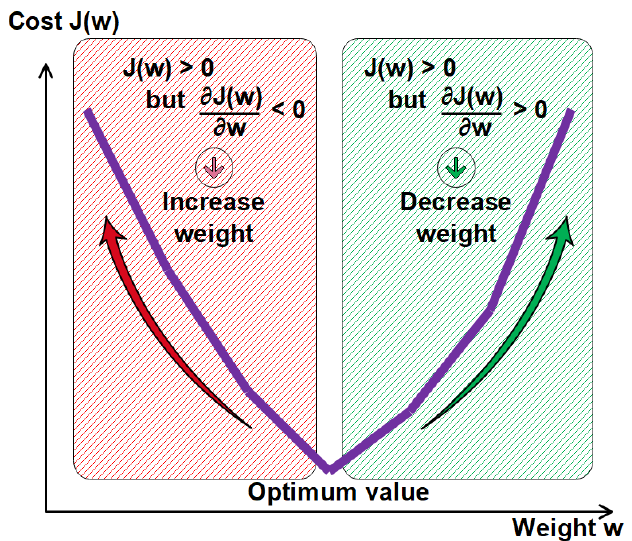
Figure 4. Relationship between cost and weight of the